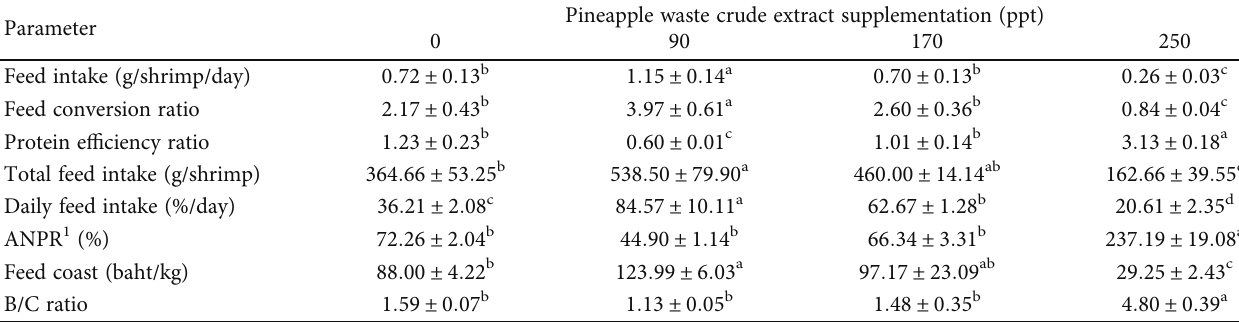
Table 2: Feed utilisation and feed cost of Paci fi c white shrimp fed with pineapple waste crude extract supplementation diet at di ff erent levels for 80